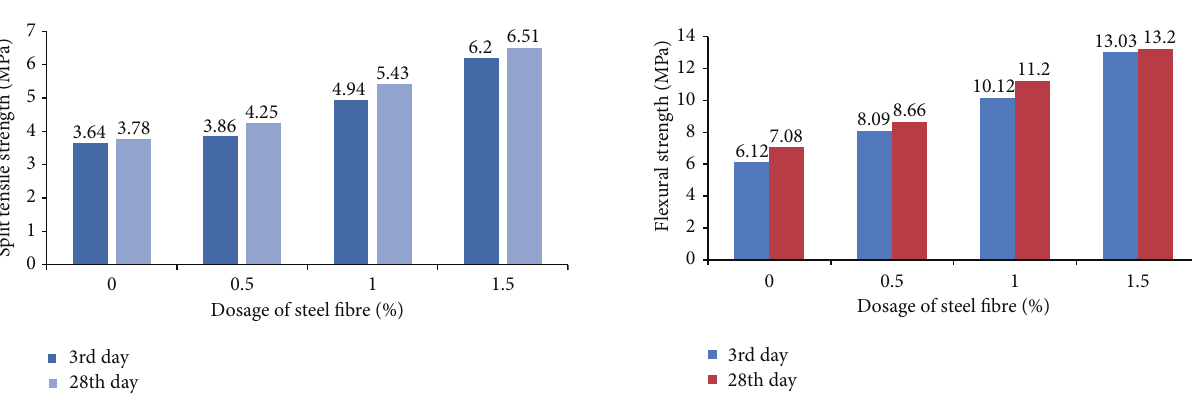
Figure 8: Split tensile strength of various volume fractions of steel fibre reinforced geopolymer concrete mixes.